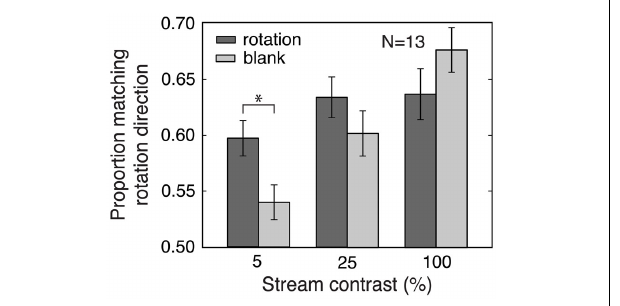
FIGURE 4 | Experiment 4: Effects of stream contrast on prediction and adaptation. Increasing the contrast of the stream items increased the size of the matching effect for the blank condition more than for the rotation condition.The prediction effect corresponds to the difference between the rotation and blank values and was greatest at the lowest stream contrast. The blank condition quantifies the effects of adaptation alone, and these effects were larger for higher stream contrasts. Error bars are SEM. ∗ p <